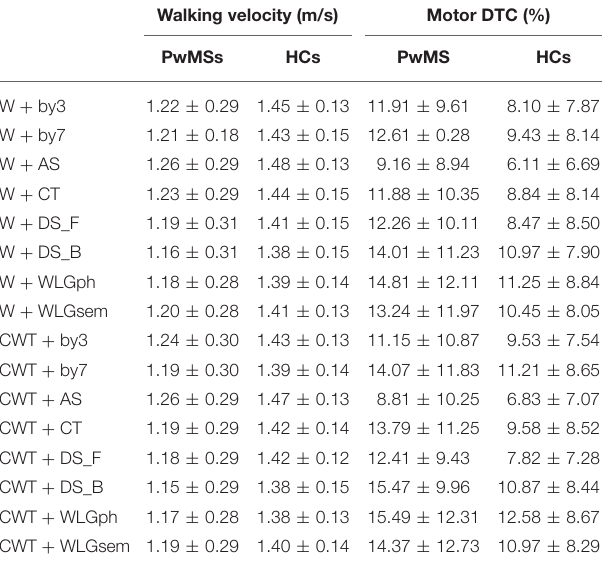
TABLE 2 | Mean gait velocity (m/s) and relative DTC (percentage) during all the single motor and cognitive-motor DT conditions (mean ± SD) presented for both pwMSs and